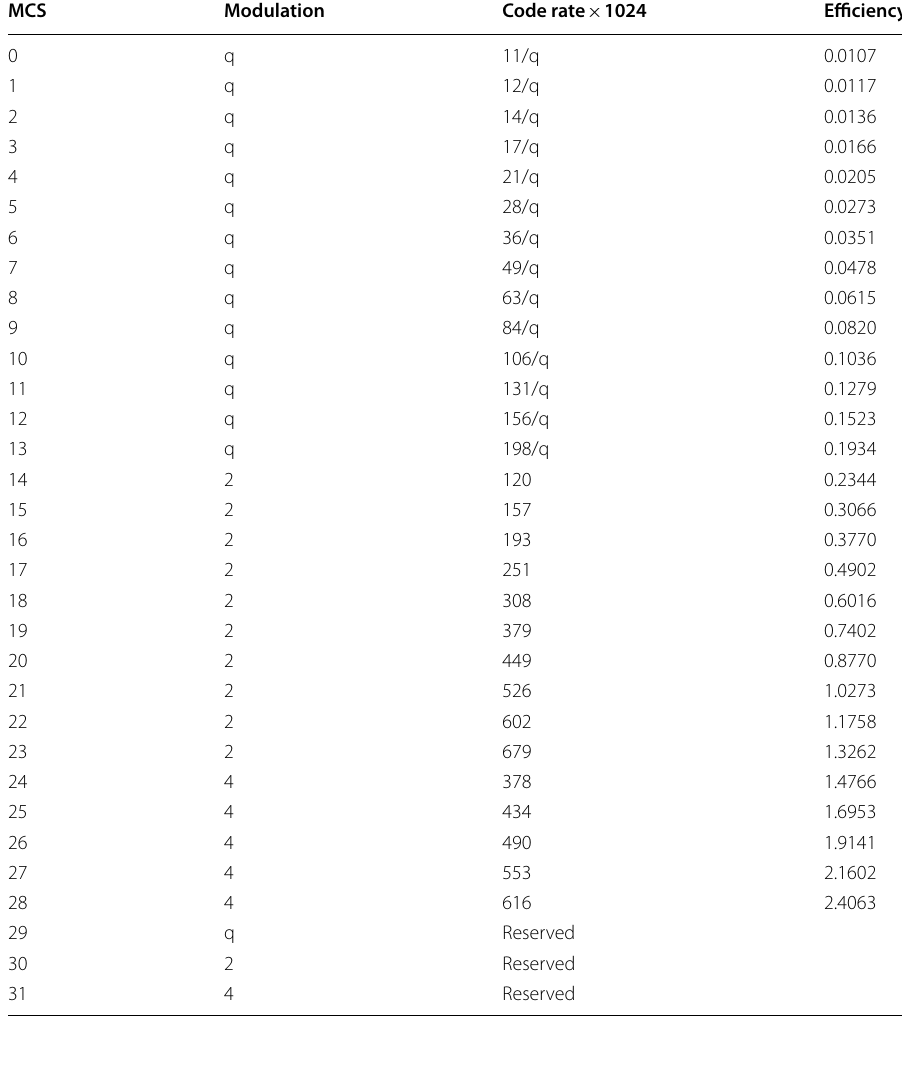
Table 6 Proposed MCS